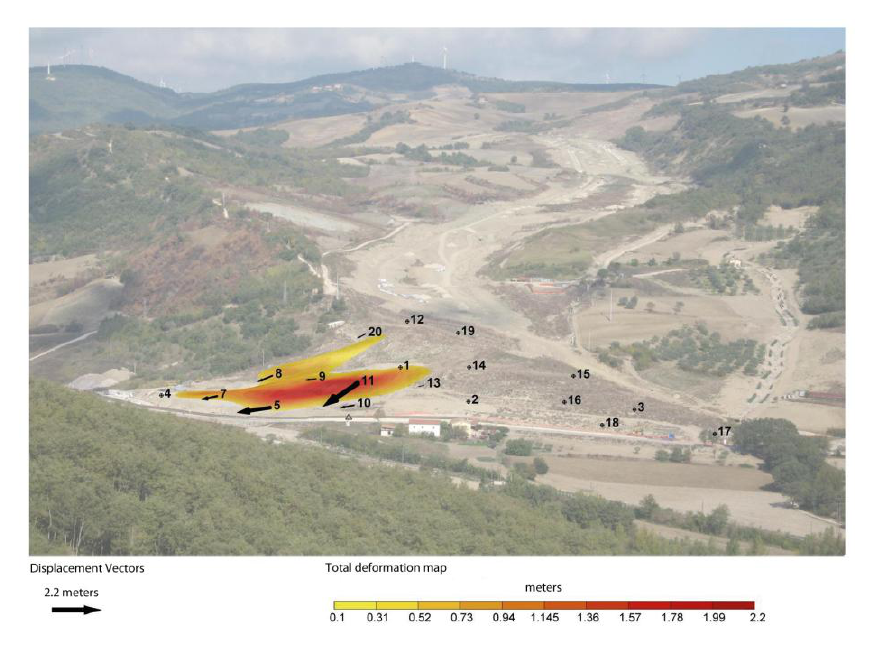
Figure 8. ©3DA representation of the same dataset shown in Figure